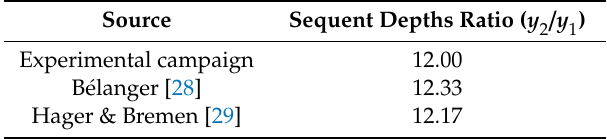
Table 3. Sequent depths ratio obtained in the physical model and with bibliographic